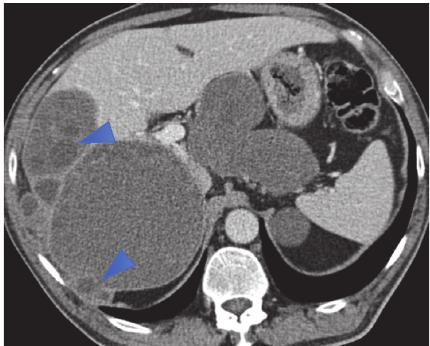
Figure 2: Axial contrast enhanced CT image nicely shows the hypodense lesions with water density and multiple smaller cysts at the periphery of the larger cysts (daughter cysts,